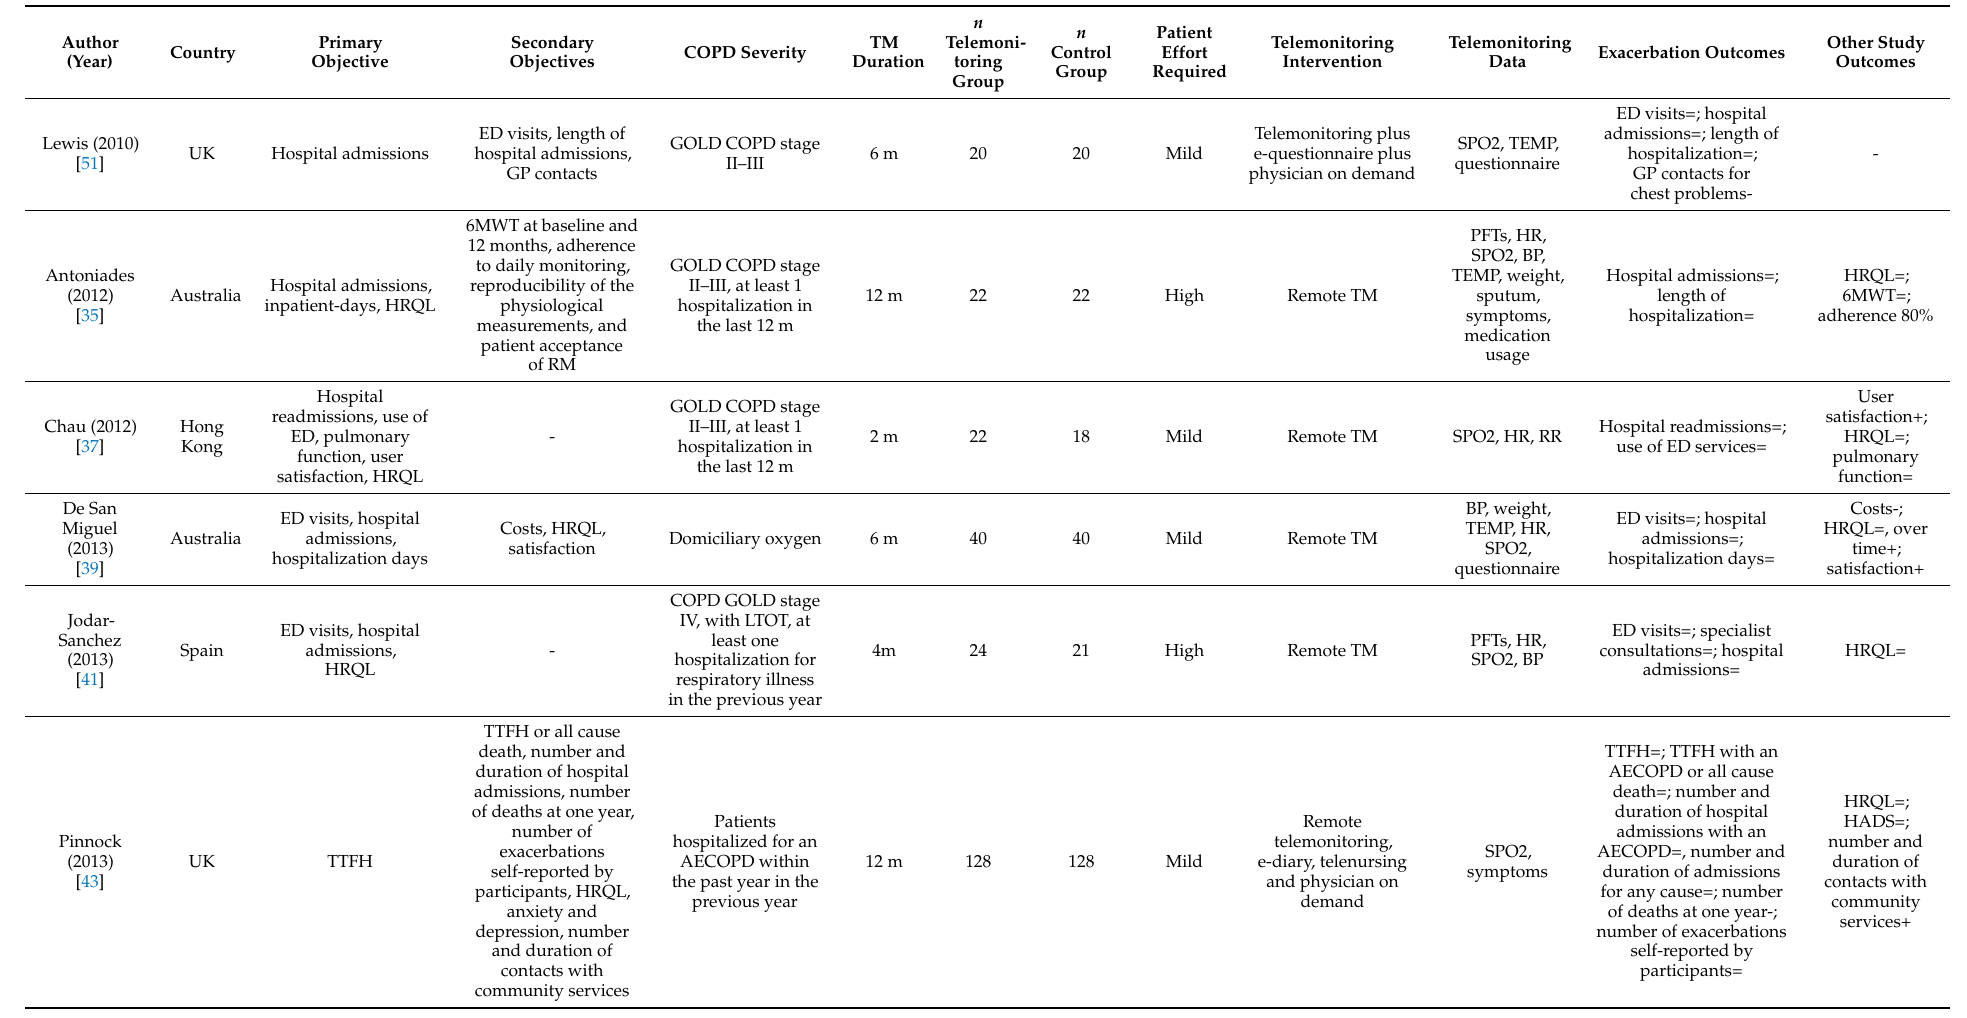
Table 2. Telemedicine studies showing negative